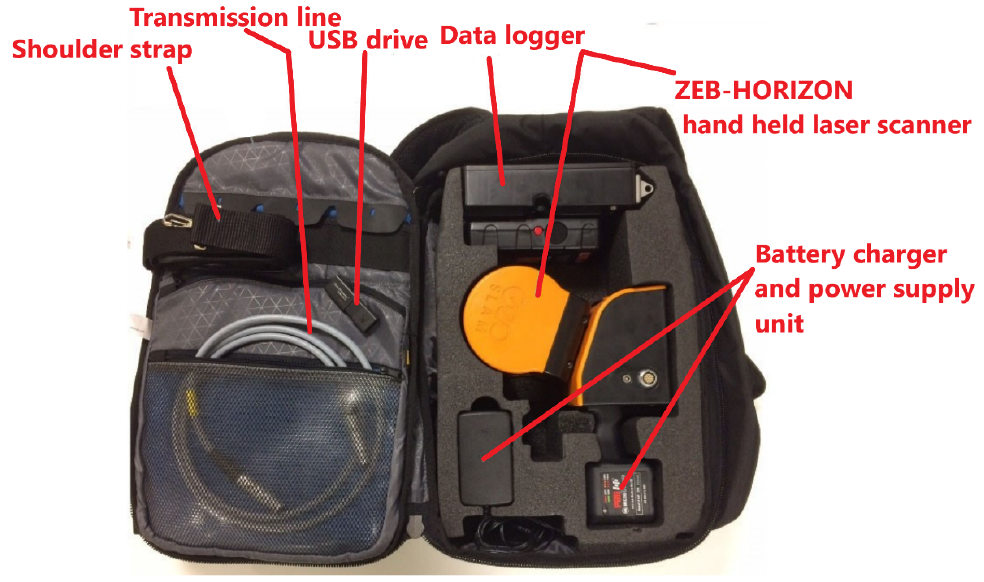
Figure 4. ZEB-HORIZON equipment diagram.